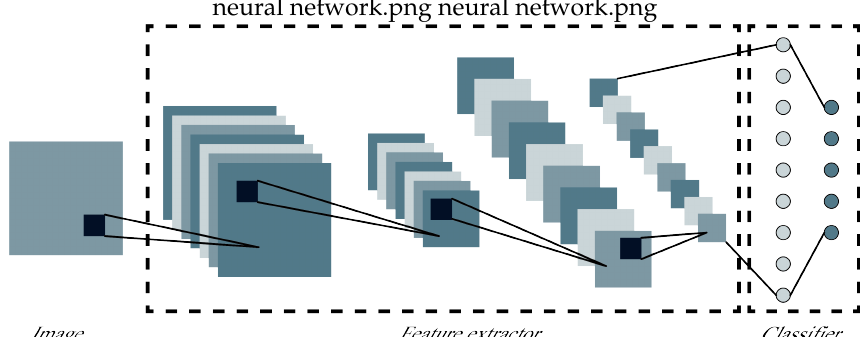
Figure 1. General CNN structure. Consisted to feature extractor and classifier.